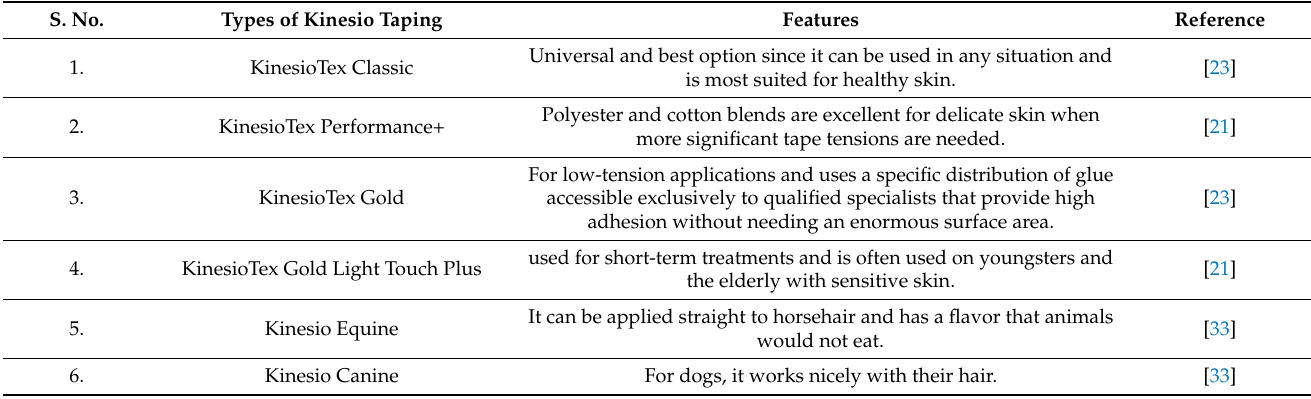
Table 1. Types and Features of Kinesio